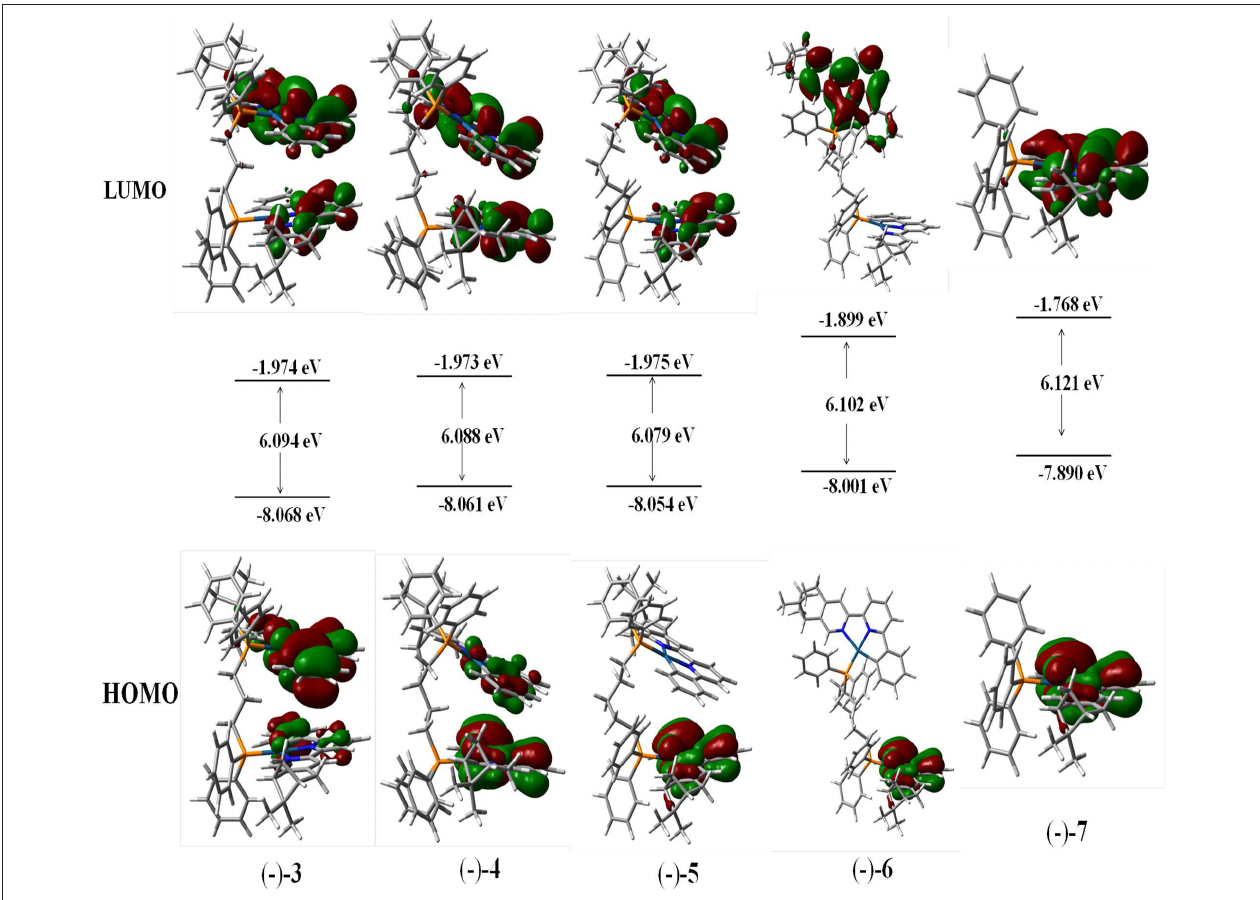
FIGURE 4 | Contour plots of the highest occupied (HOMO) and lowest unoccupied (LUMO) molecular orbitals of (–)- 3 , (–)- 4 , (–)- 5 , (–)- 6 , and (–)- 7 .